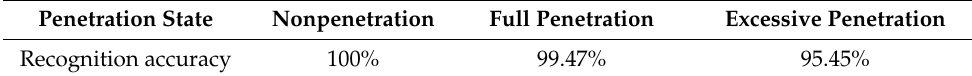
Table 4. Recognition accuracy of the penetration state under different data sets of training set.